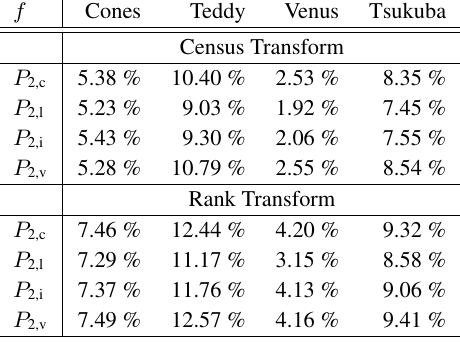
Table 1: Errors in non-occluded areas with a threshold of 1 dis- parity obtained with optimally parametrized penalty functions.